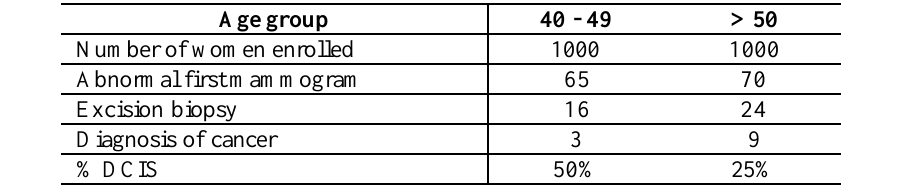
Table I : Differential implication of screening on different age groups.